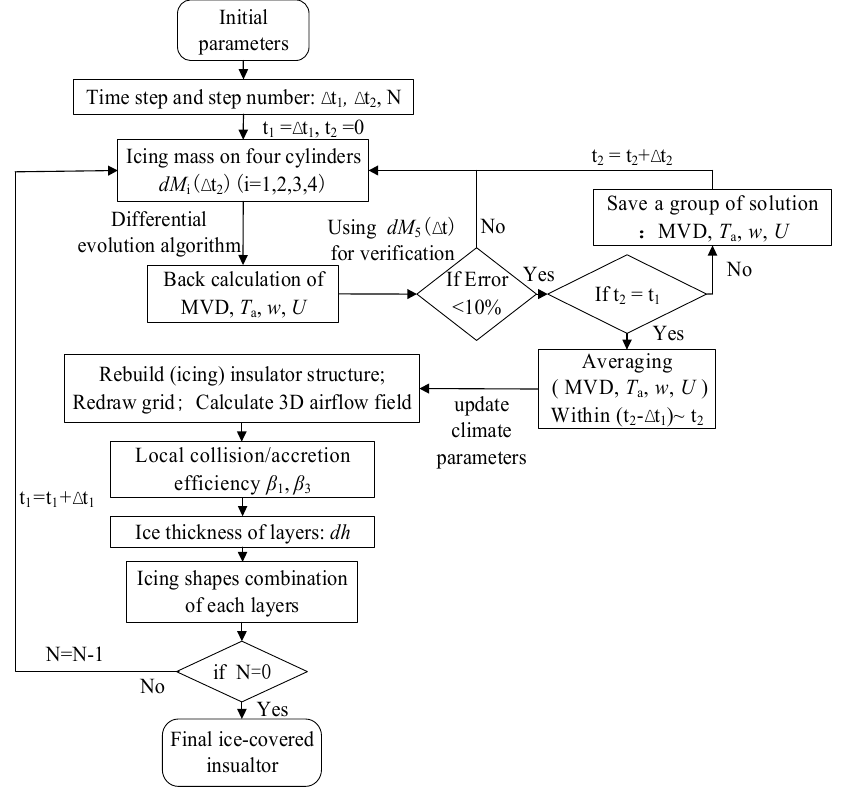
Figure 7. The dynamic calculation flow chart of dry-growth icing on insulator.